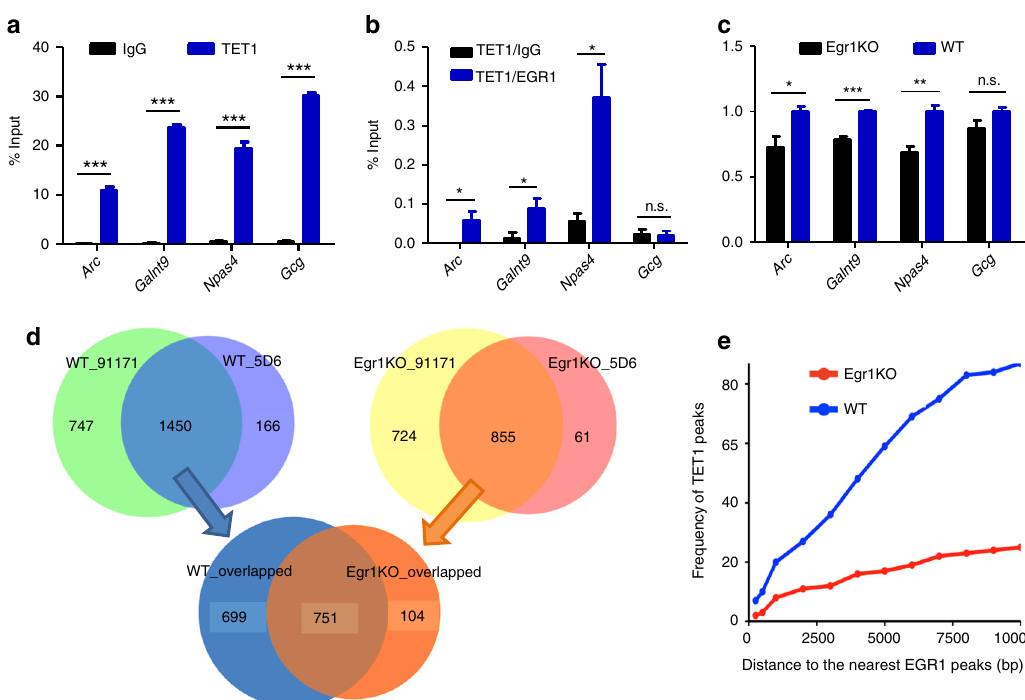
Fig. 3 EGR1 recruits TET1 to its target sites. a TET1 ChIP-qPCR assay in wild-type mouse frontal cortices. b Sequential ChIP-qPCR assay in wild-type mouse frontal cortices. The fi rst antibody used was anti-TET1; the secondary antibody used was anti-EGR1 and normal rabbit IgG. Gcg locus serves as negative control for EGR1 binding. c ChIP-qPCR assay in frontal cortices of Egr1KO and wild-type mice. TET1 enrichment is normalized to the enrichment in WT. P -values were calculated with t -test, * P < 0.05, ** P < 0.01, *** P < 0.001. n.s., not signi fi cant. Error bars ± standard deviation (s.d.) from three technical replicates. d Venn diagrams show the overlapped TET1 peaks generated with two distinct antibodies (91171 and 5D6, Active Motif) or from WT and Egr1KO frontal cortices. e The distribution of TET1 peaks relatively to their nearest EGR1 peaks. The distance of TET1 peak to its nearest EGR1 peak refers to the number of nucleotides between the centers of two